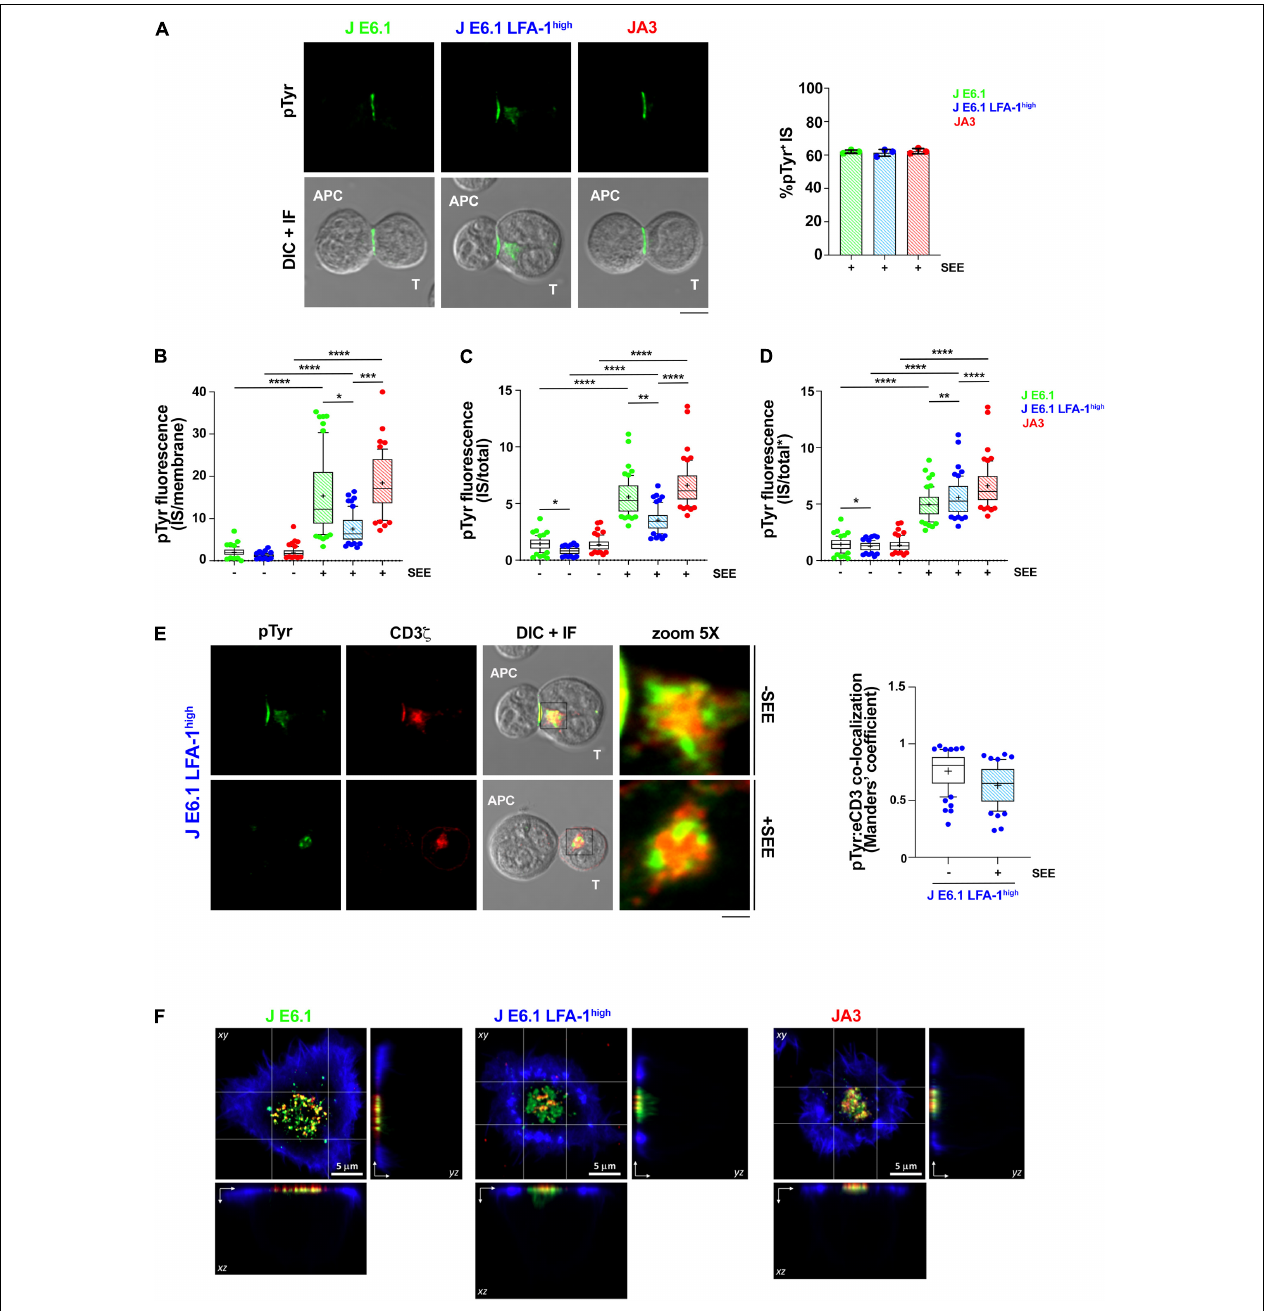
FIGURE 3 | Increasing LFA-1 expression in E6.1 cells does not improve phosphotyrosine signaling at the IS in conjugates with SEE-loaded APCs. (A) Immunofluorescence analysis of tyrosine phosphoproteins (pTyr) in 15-min conjugates of E6.1, E6.1 LFA-1 high or JA3 Jurkat cells and SEE-pulsed Raji cells (APC). Representative images are shown. The histogram shows the percentage (mean ± SD) of conjugates with pTyr staining at the T-cell:APC contact (right; unpaired Student’s t -test; n > 40 conjugates/sample from three independent experiments). (B) Quantification of the relative mean fluorescence intensity (MFI) of anti-pTyr at the IS membrane versus the mean of anti-pTyr MFIs measured at three different membrane regions of the same size outside of the T-cell:APC contact (mean ± SD; Kruskal–Wallis test; n ≥ 20 conjugates/sample from three independent experiments). Graph boxes represent 10–90 percentile and the mean is shown as “+.” (C) Quantification of the relative mean fluorescence intensity (MFI) of anti-pTyr at the IS membrane versus the MFI of the whole T cell (total) (mean ± SD; Kruskal–Wallis test; n ≥ 20 conjugates/sample from three independent experiments). Graph boxes represent 10–90 percentile and the mean is shown as “+.” (D) Quantification of the relative mean fluorescence intensity (MFI) of anti-pTyr at the IS membrane versus the MFI of the whole T cell excluding the intracellular pTyr pool in E6.1 LFA-1 high cells (total*) (mean ± SD; Kruskal–Wallis test; n ≥ 20 conjugates/sample from three independent experiments). Graph boxes